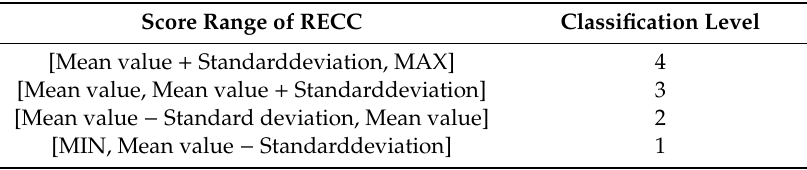
Table 2. The division criteria of the RECC level.